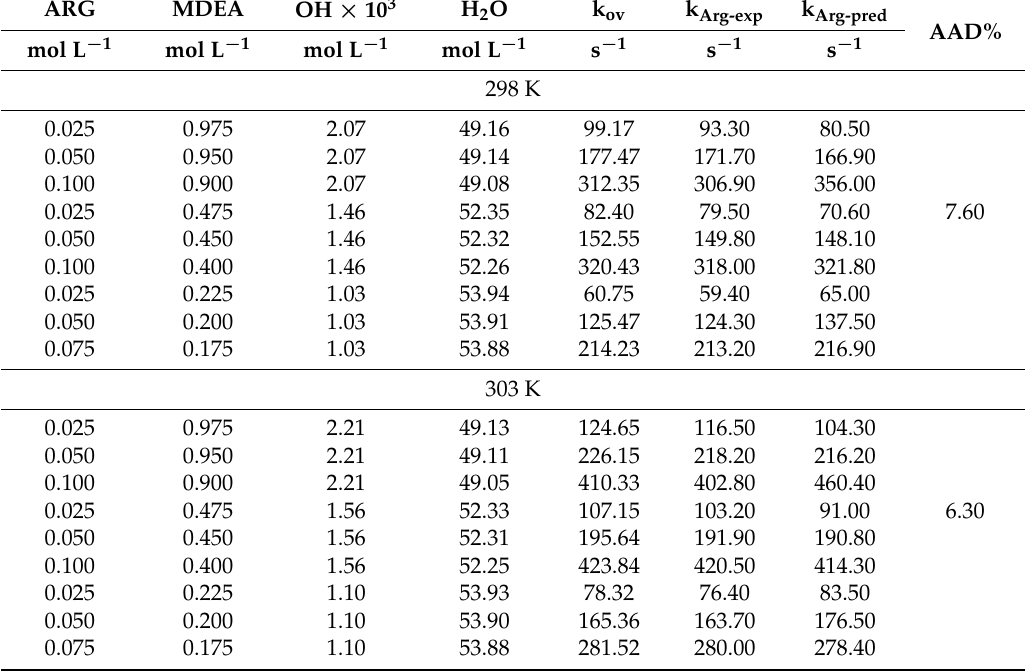
Table 1. Rate constants at different temperatures and (MDEA+Arg)